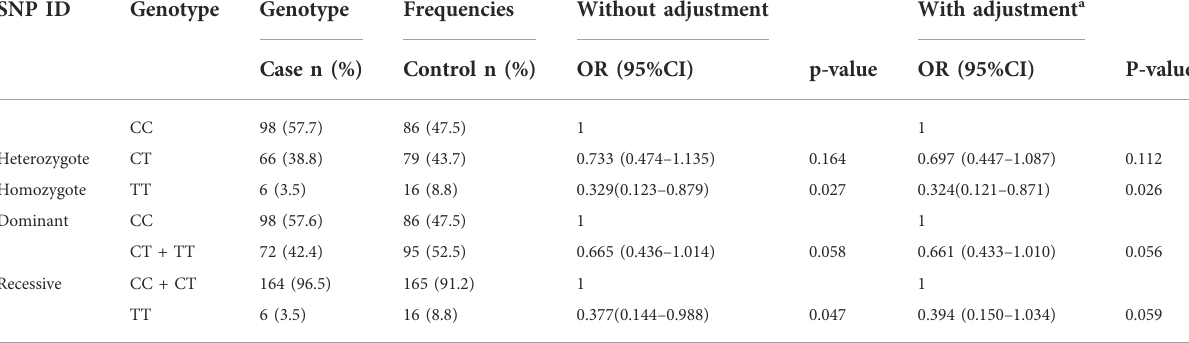
TABLE 5 Association between rs3775291 and risk of COPD in different inheritance